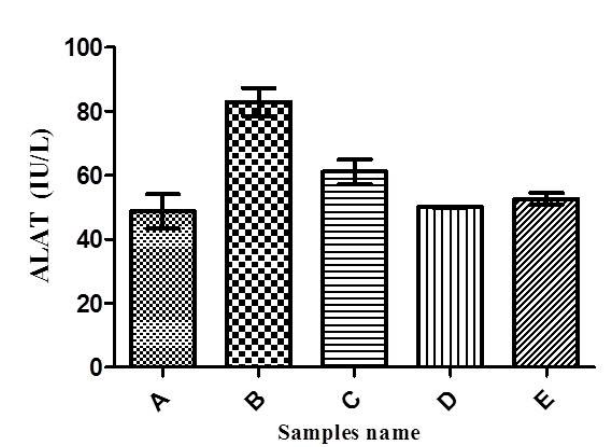
FIGURE 3 - ALAT content in serum samples following treatment with iron dextran and iron chelators A: control group, B: iron-overloaded mice, C: iron-overloaded mice receiving DFO, D: iron-overloaded mice receiving 30 mg/ kg/day naringin, and E: iron-overloaded mice receiving 60 mg/kg/day